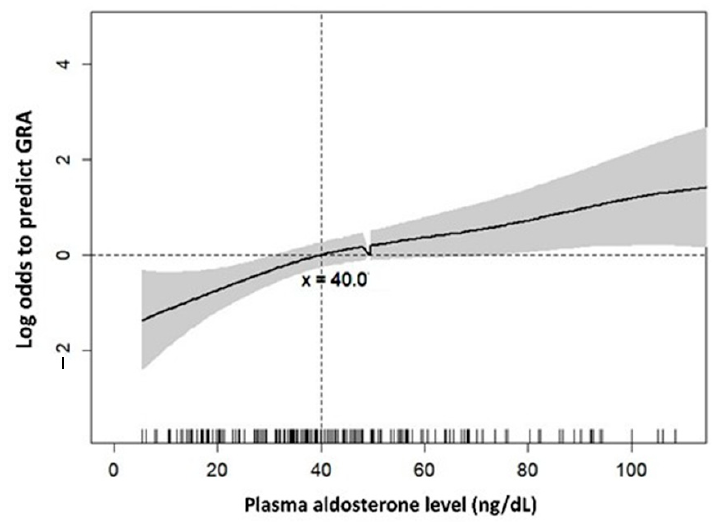
Figure 1. Generalized additive model (GAM) plot for plasma aldosterone and log odds to predict GRA. Figure 1 depicts the GAM plot for the probability of plasma aldosterone against GRA-positive patients, incorporating the subject-specific (longitudinal) random effects expressed as the logarithm of the odds. The probability of outcome events was constructed with age-adjusted variables over the range of data, and plasma aldosterone = 40. The dashed lines represent approximated pointwise 95% CI. Dotted curves indicate 95% CIs for the smoothed hazard.